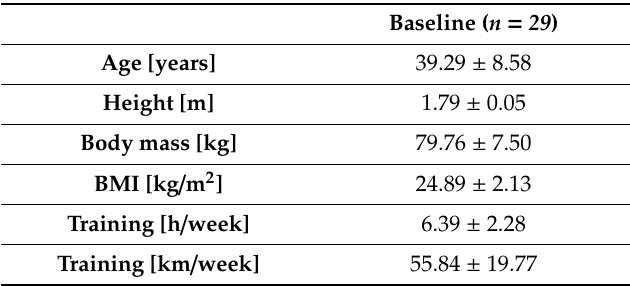
Table 1. General characteristics of